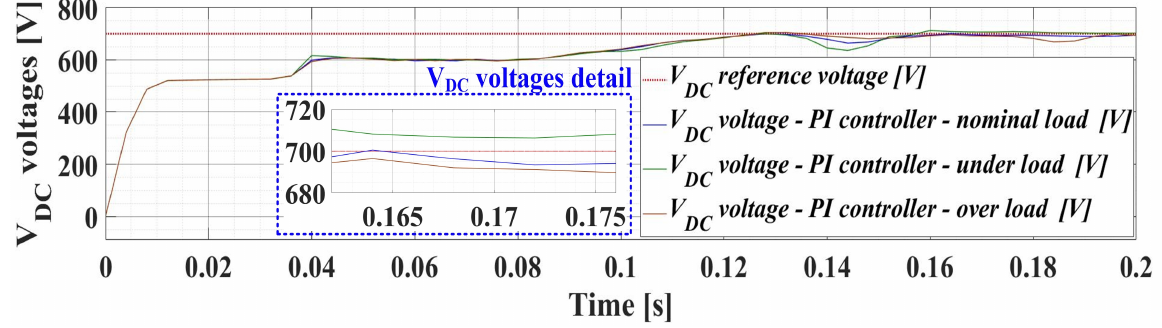
Figure 9. V DC voltages time evolution of the UPQC-APF control system based on PI-GWO controller in case of nonlinear load. Figure 10. V DC voltages time evolution of the UPQC-APF control system based on FO-PI controller in case of nonlinear load. Figure 11. V DC voltages time evolution of the UPQC-APF control system based on TID controller in case of nonlinear load.